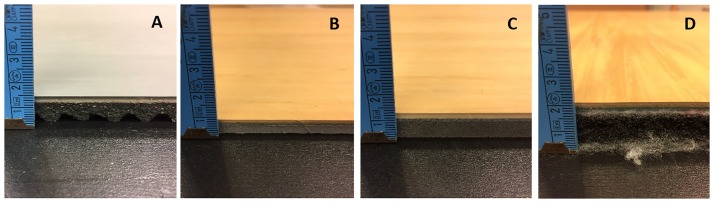
Sports floorings used for the study.A: Sports flooring 1 (SF1 = 14 mm); B: Sports flooring 2 (SF2 = 7.5 mm); C: Sports flooring 3(SF3 = 11 mm); D: Sports flooring 4 (SF4 = 18 mm).